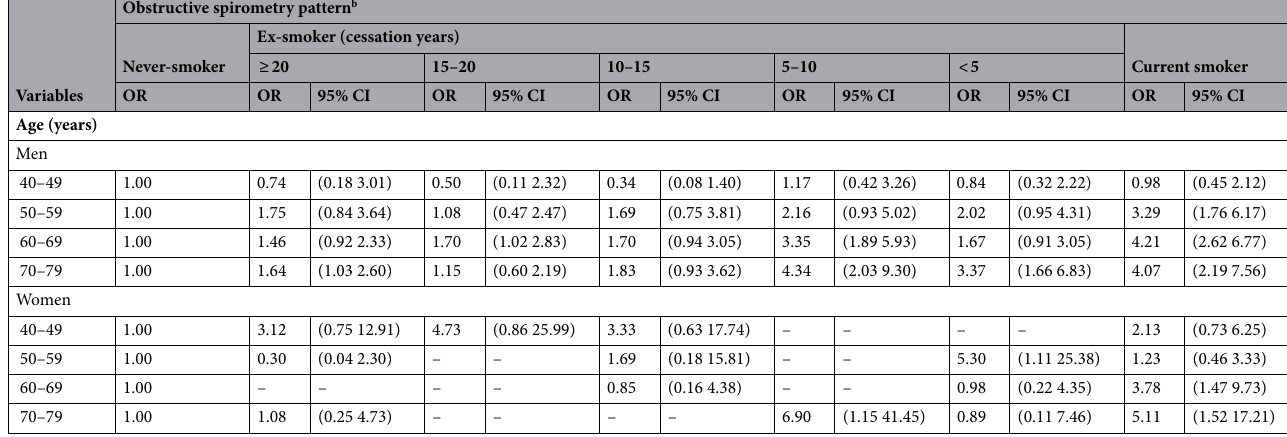
Table 3. Association between smoking cessation status and obstructive spirometry pattern according to age group a . OR odds ratio, CI confidence interval. a Adjusted for all covariates (cumulative smoking exposure, age, educational level, household income, occupation, residential area, physical activity, high-risk drinking, and height). b Obstructive spirometry pattern was defined as an FEV 1 /FVC <